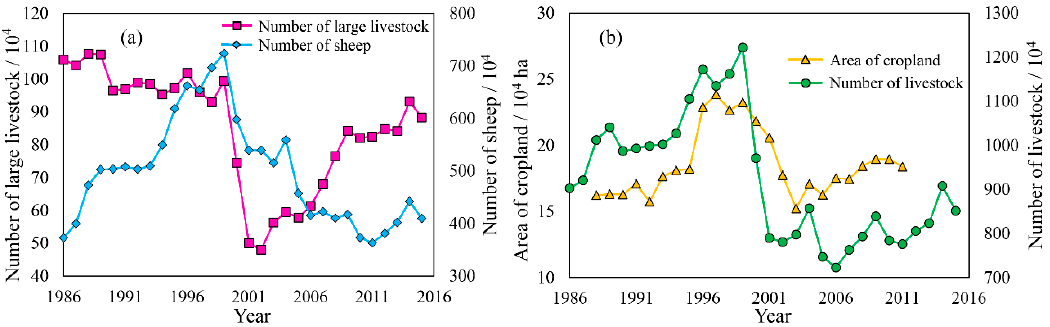
Figure A6. Change trend of livestock number and cropland area in OSL. ( a ) Trends in large livestock and sheep; ( b ) Trends of livestock quantity and cropland area .